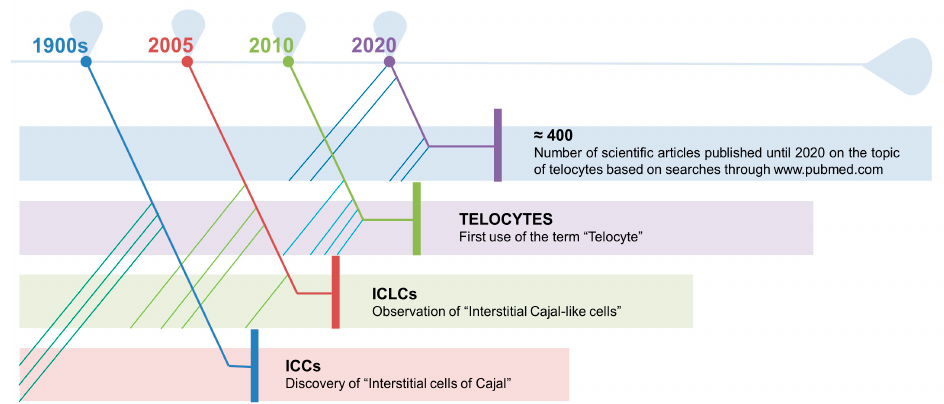
Figure 1. At the beginning of 1900, Santiago Ramón y Cajal described the presence of what he considered primitive interstitial neurons in the loose connective tissue of the tunica muscularis of the gut. Half a century later, M.S. Faussone-Pellegrini and L. Thuneberg observed that these cells were not neurons and called them “Interstitial Cells of Cajal (ICCs)”. These type of cells were then found in many other organs. Finally, Faussone-Pellegrini together with L. M. Popescu, proposed, in 2010, to use the term “Telocyte” to indicate an ICLC. Since their identification, TCs have received attention and the number of scientific articles on the topic is growing considerably.